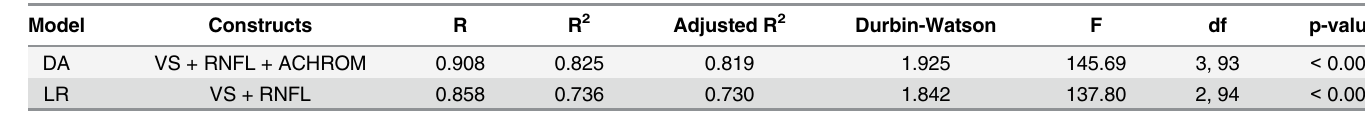
Table 4. Independently correlated eye-related constructs and left ventricular function. Model